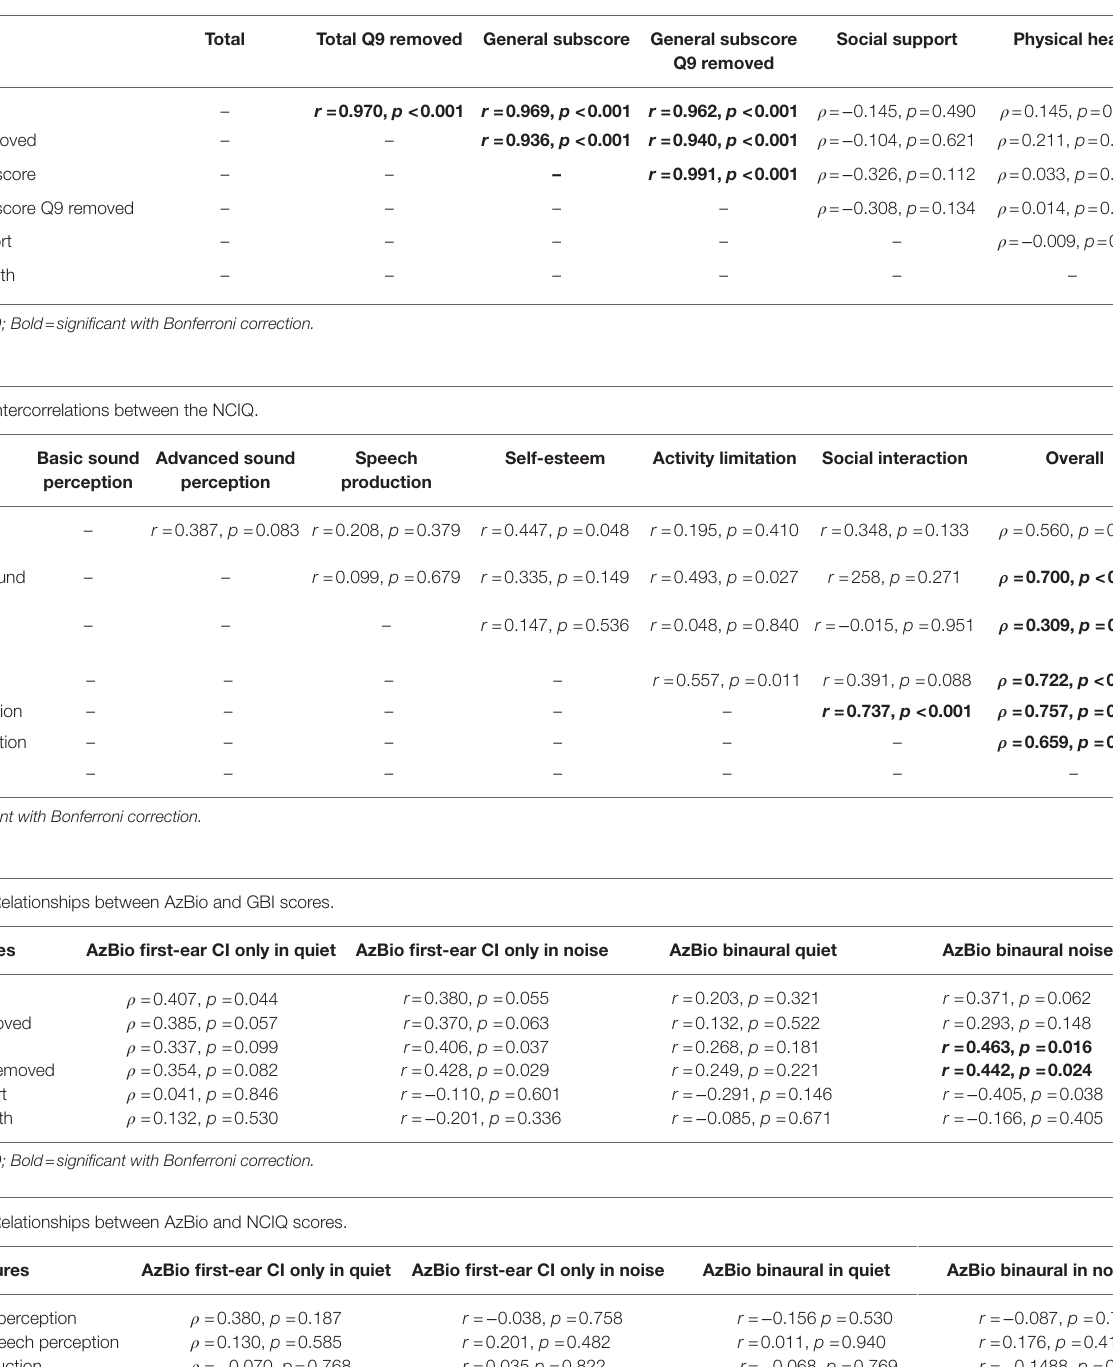
TABLE 1 | Intercorrelations between the